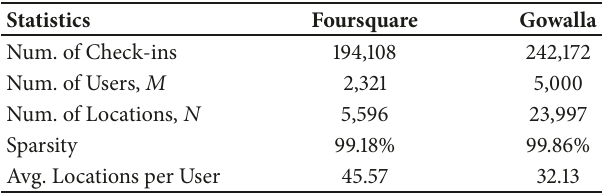
Table 1: Statistics of Foursquare and